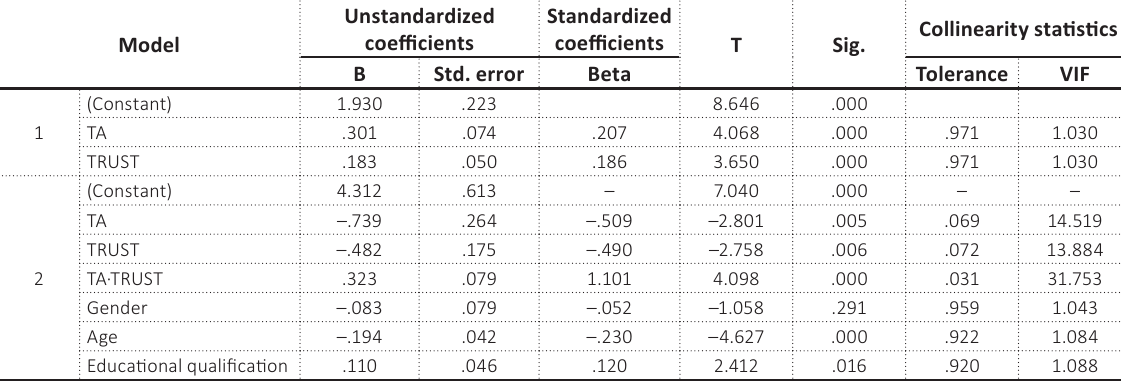
Table 4. Regression results of study variables